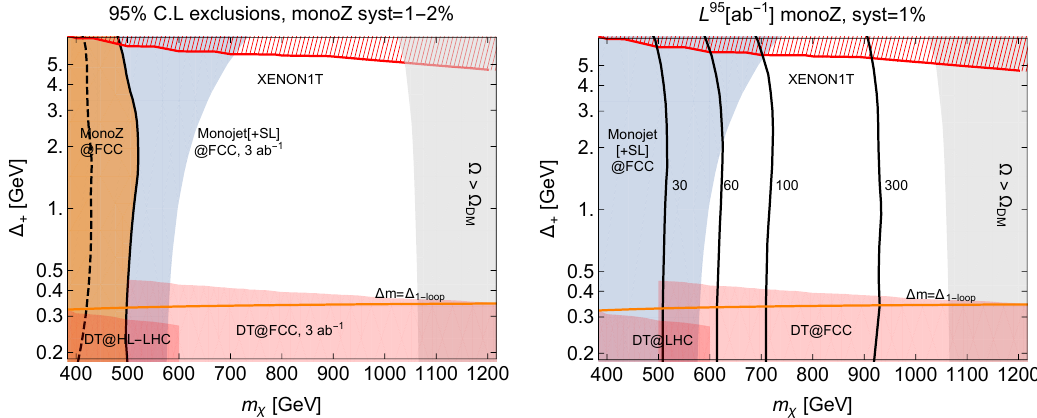
Figure 8 . Higgsino parameter space covered by the existing studies and the proposed mono-Z search. (Left panel) The 95% CLs exclusion for our dileptonic mono- Z search, for 30 ab (cid:0) 1 of integrated luminosity at FCC-hh, and a background systematic uncertainty of 1% (solid black line) and 2% (dashed black line). Note that the other collider searches shown use a lower luminosity of 3 ab (cid:0) 1 . For more details see caption of (cid:12)gure 7 and text. (Right panel) Contours of luminosity required for 95% CLs exclusion, L 95 , for 1% systematic uncertainty in the